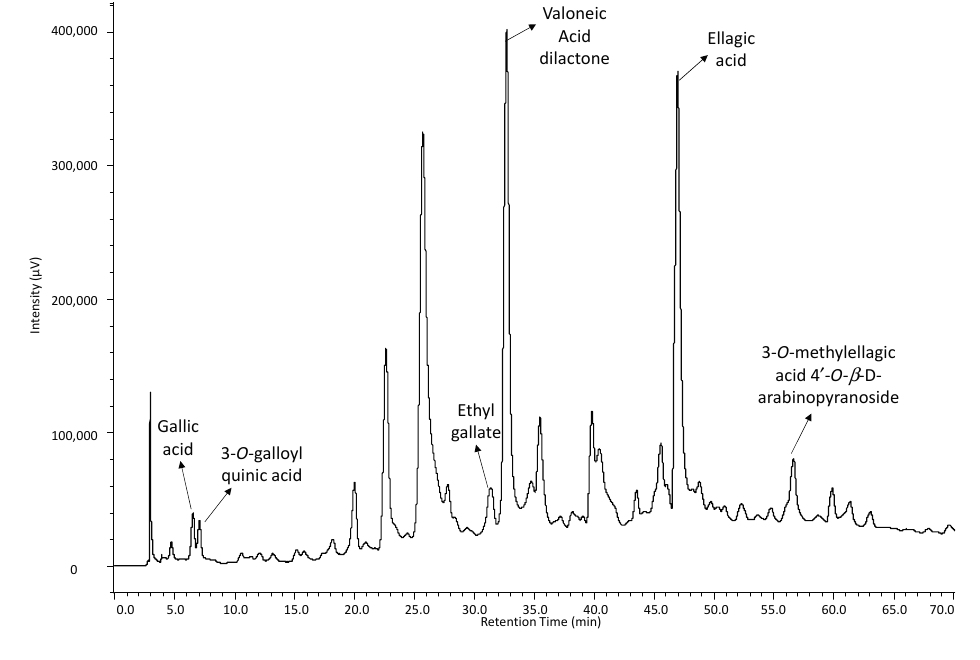
Figure 3. HPLC-DAD chromatogram of the ethanolic extract of the stem bark from C . ferrea